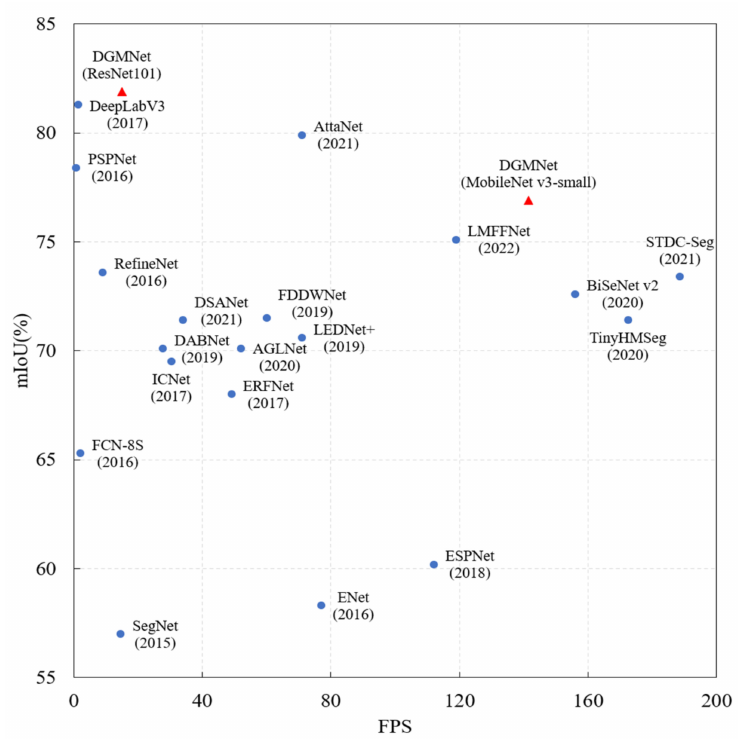
Figure 1. Comparison of the reasoning speed (FPS) and mIoU (%) of different networks on the test dataset of